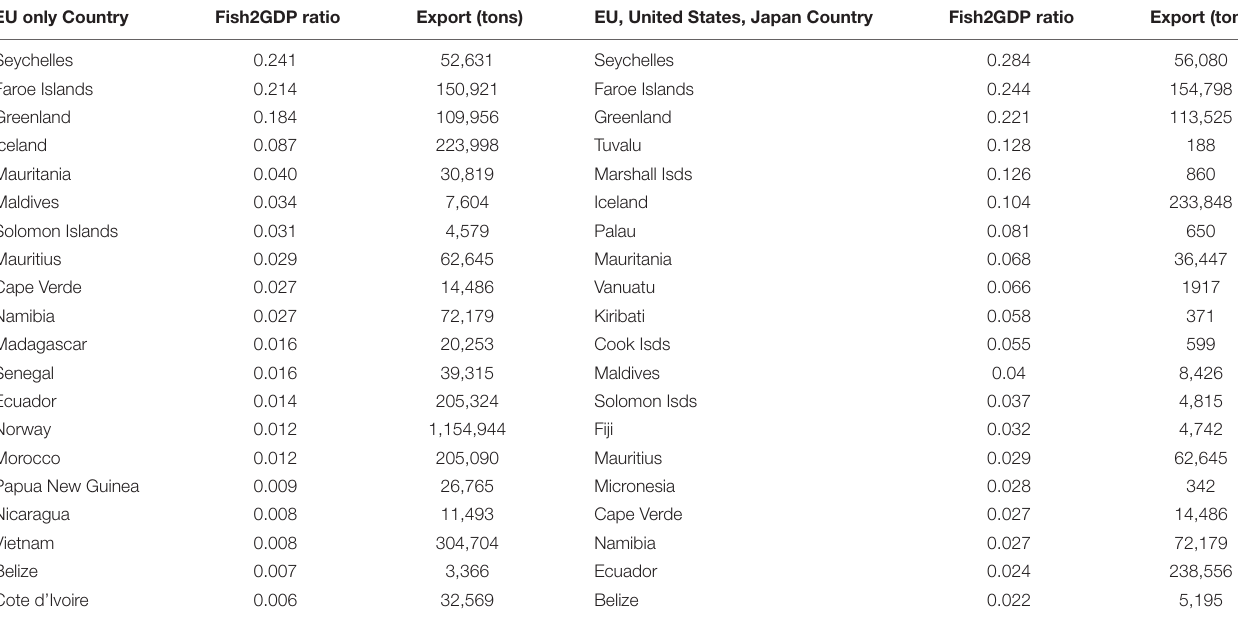
TABLE 5 | Top Fish2GDP ratio ∗ of fish exporting countries to the EU only and to the EU, the United States and Japan combined. EU only